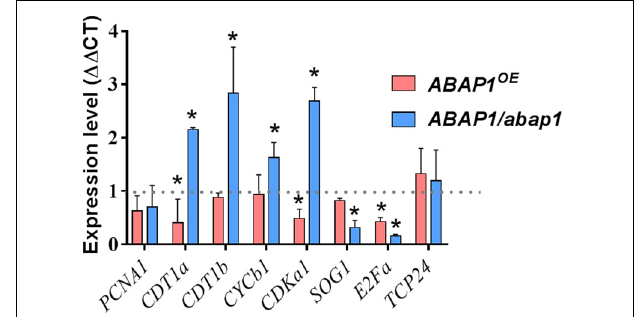
FIGURE 8 | qRT-PCR assays revealed a regulation of cell cycle genes in galls induced by M. incognita in ABAP1 OE and ABAP1/abap1 plants. PCNA , CDT1a , CDT1b , CYCB1;1 , CDKA;1, SOG1 , and E2Fa were up- or downregulated upon knockdown or overexpression of ABAP1 in galls. The analysis was performed in galls 14 days after inoculation, when cell cycle activity is high. AtOxaloacetate and AtNAPDH genes were used as endogenous reference genes. Data represent mean ± SEM of three independent experiments. The values were normalized according to mRNA levels of wild-type controls (WT-Col-0 for ABAP1/abap1 and WT-Ler for ABAP1 OE ) (dashed black line). Asterisks indicate values statistically different from the wild-type (Student’s t -test, P =